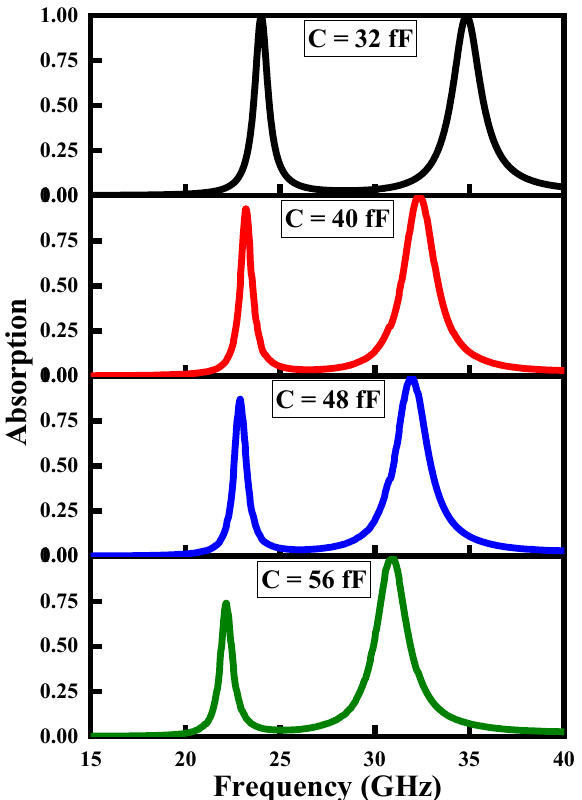
Figure 2. Tuning mechanism of absorption rate of the proposed MMA at different capacitance values of the varactor diode; here, C shows the value of the capacitance of the varactor diode.